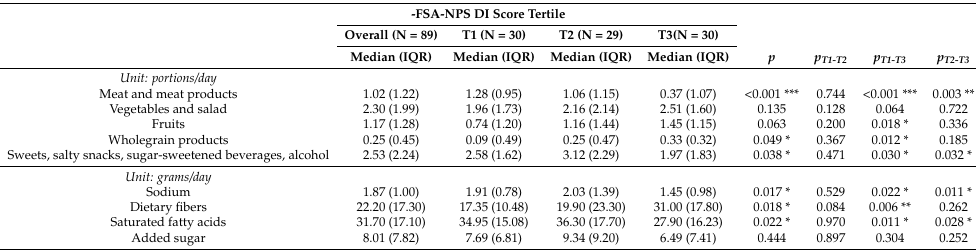
Table 8. Median and interquartile range (IQR) of the absolute nutritional intake across the tertiles of the inverted Food Standards Agency Nutrient Profiling System Dietary Index (-FSA-NPS DI) a